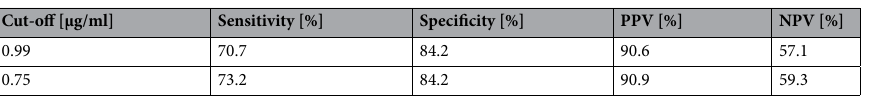
Table 3. Variables for diagnostic performance of the hyperspectral camera as a function of different cut-off PPIX contributions.